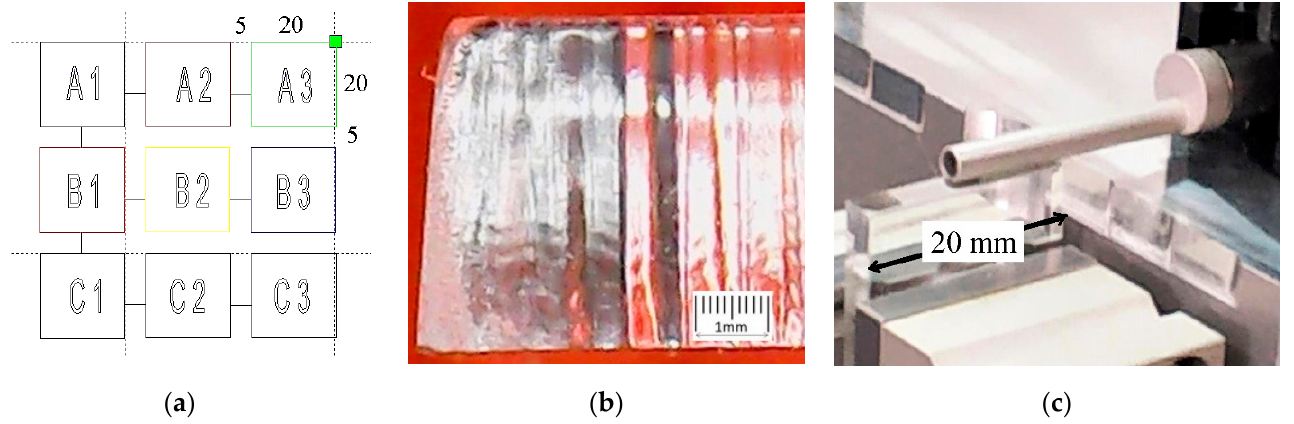
Figure 3. ( a ) Laser cut footprint of the test pieces; ( b ) cut surface texture, ( c ) Ra measurement. A micrometre with a range of 0–25 mm and 0.01 mm precision was utilised for the dimensional readings—the average (AV) of three measurements calculated in both X and Y directions. Then the dimensional accuracy was calculated by subtracting the ‘average’ from the ‘nominal’ dimension (20 mm) for each direction.